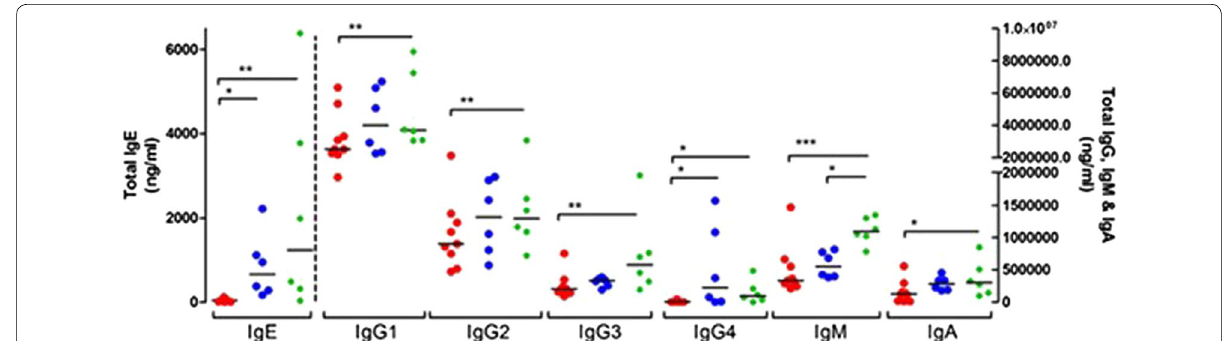
Fig. 1 Total IgE, IgGs, IgM and IgA (ng/mL) in children with CM‑FPIES (red), IgE‑CMA (blue) or IgE‑PNA (green). * p < 0.05, ** p < 0.01, *** p < 0.001 using Kruskal–Wallis and Dunn’s multiple comparison test